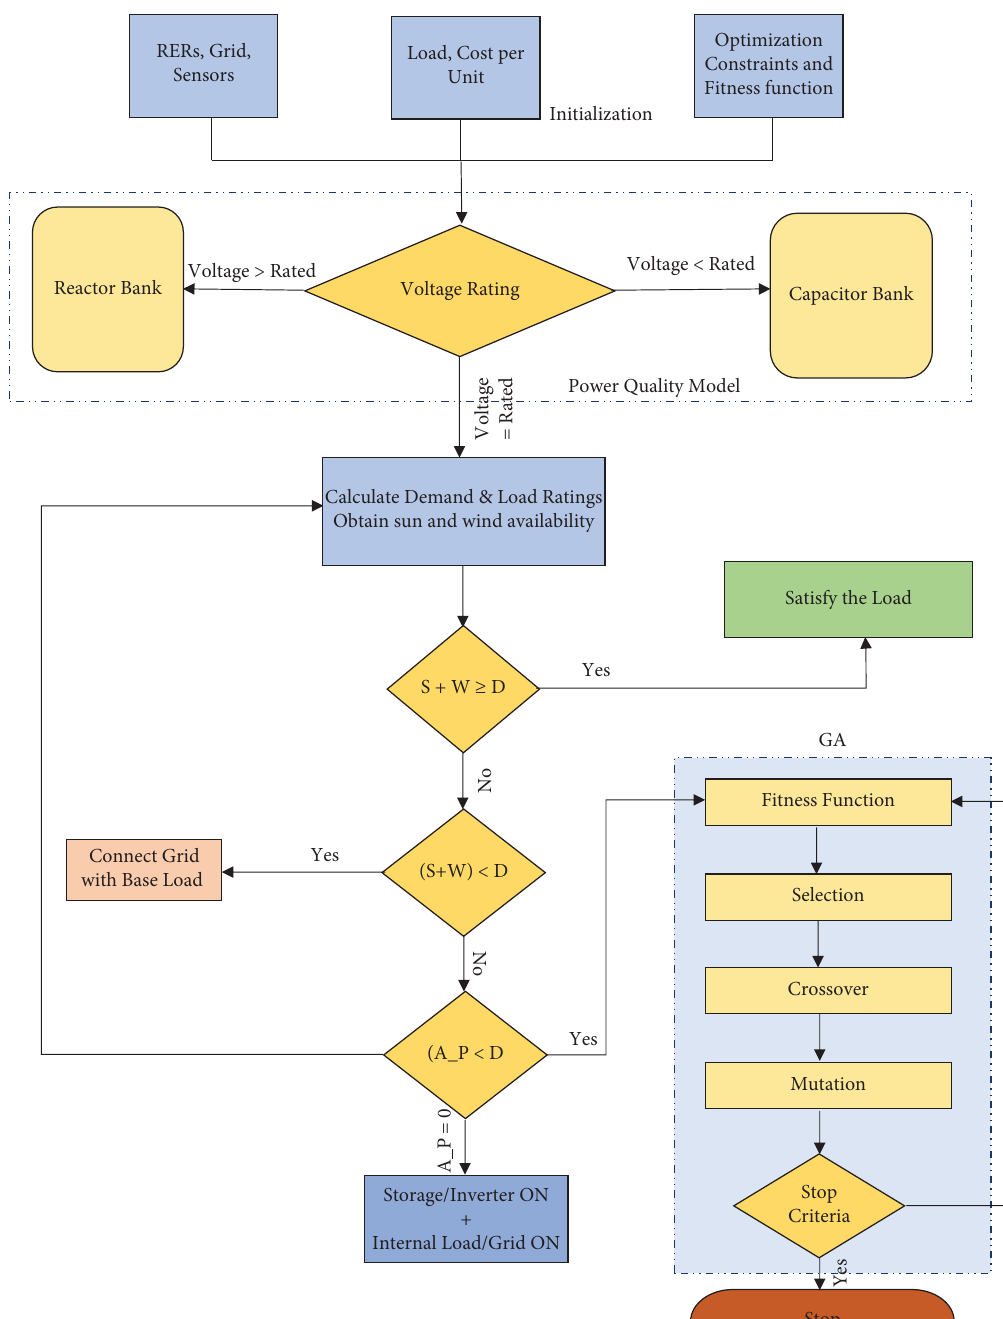
Figure 3: Te fowchart of the proposed